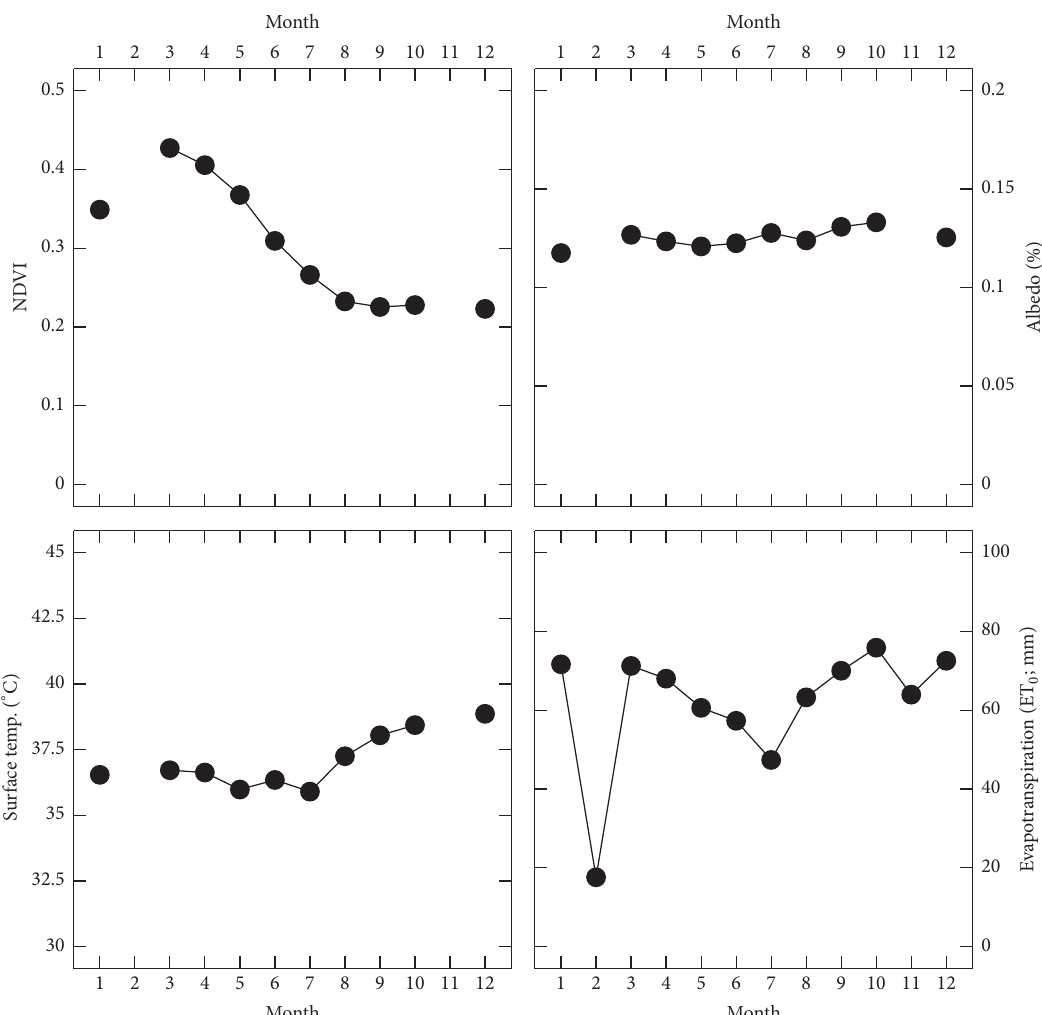
Figure 3: Monthly variation of all input parameters used in the SAFER algorithm for the year of 2012 in an area of Caatinga at Embrapa Semi´arido, which is a research station of the state of Pernambuco, Brazil. NDVI, albedo, and Surface Temperature are presented as monthly mean of all available data and evapotranspiration is the monthly mean of all available data multiplied by the number of days in that